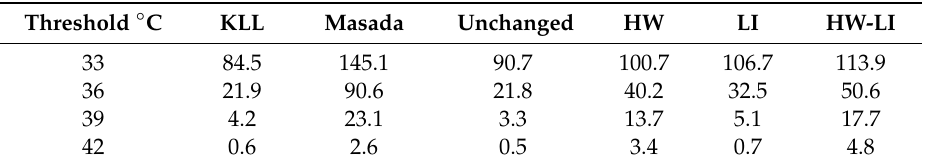
Table 3. Number of days with air temperatures above certain thresholds in measured and simulated time series. KLL refers to the on-lake measurement station operated by the Kinneret Limnological Laboratory, Israel Oceanographic and Limnological Research, and the Masada station is located < 3 km south of the lake. The KLL station is the one that was used for calibrating the vector-autoregressive weather generator (VG). Threshold ◦ C KLL Masada Unchanged HW LI HW-LI 33 84.5 145.1 90.7 100.7 106.7